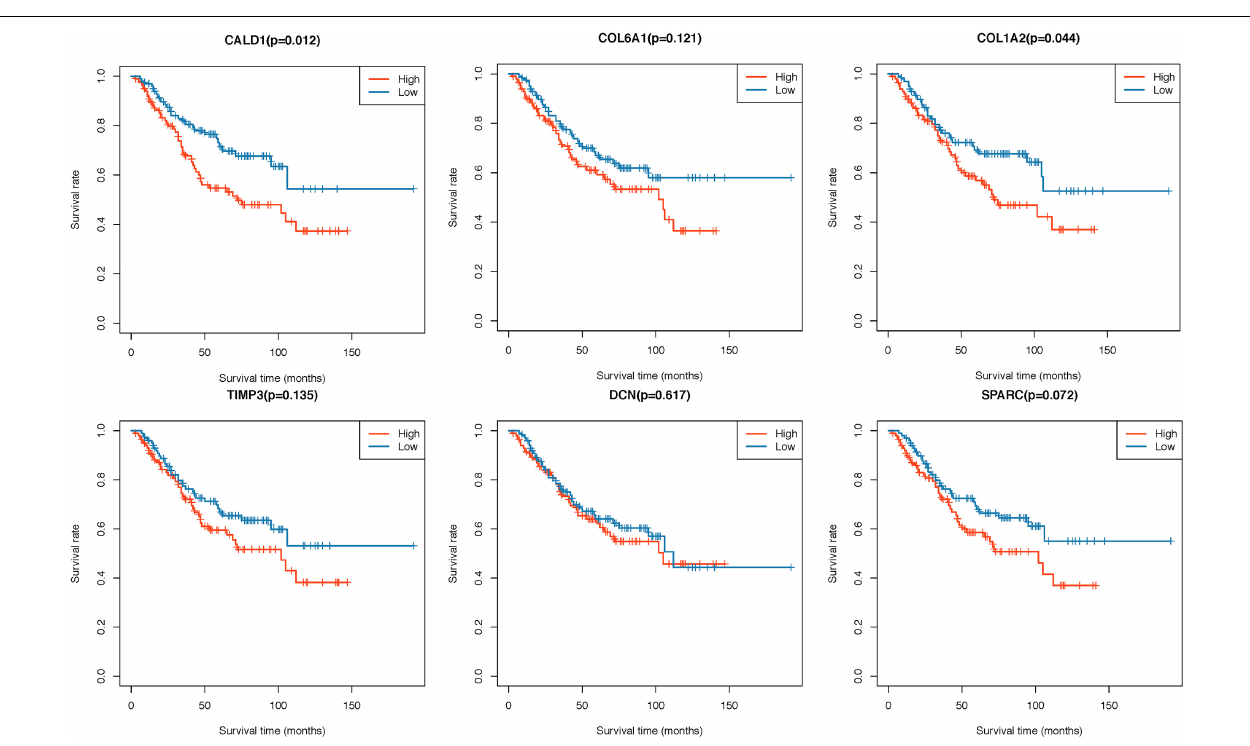
Frontiers in Molecular Biosciences |